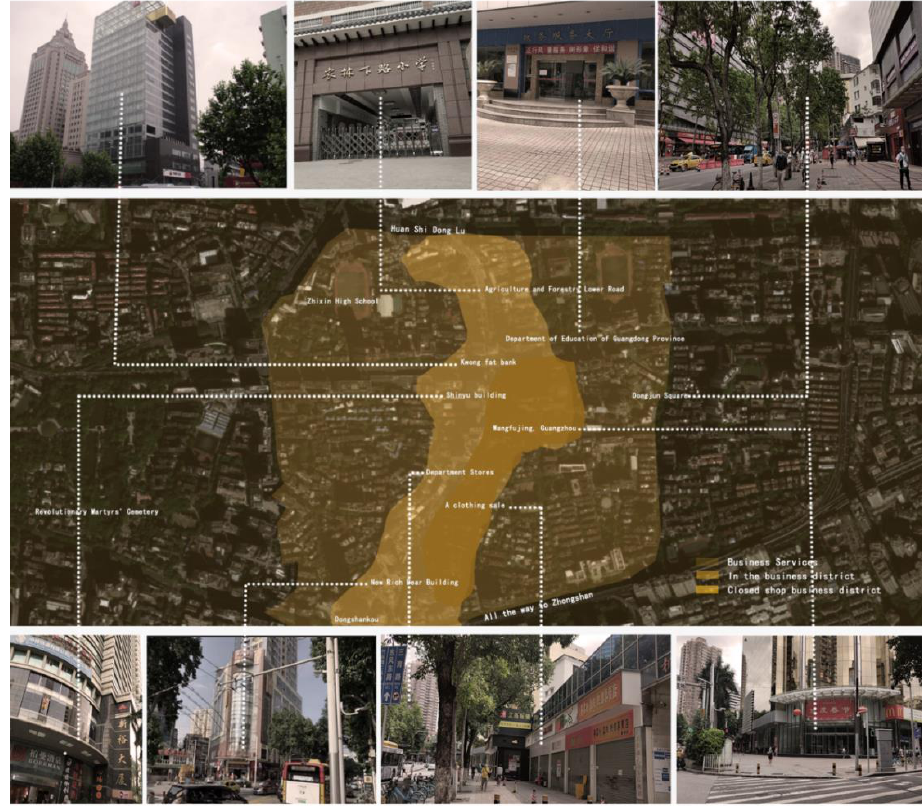
Figure 3. Location and status of Nonglin Street.